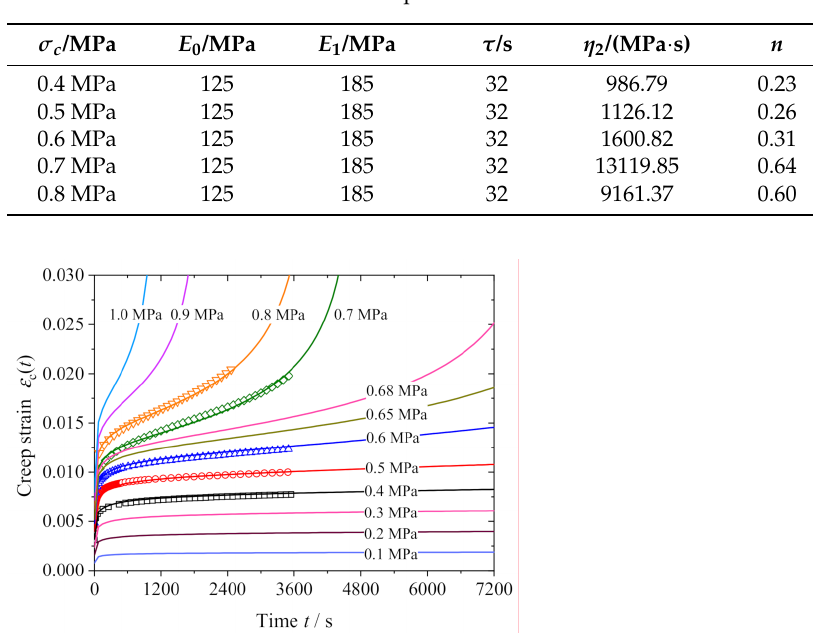
Table 5. The modified Nishihara model parameters.